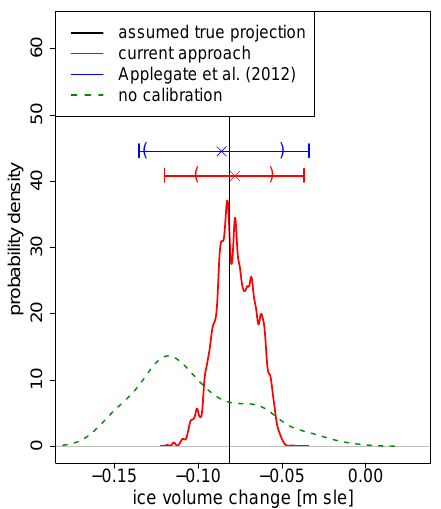
Figure 5. Illustrative (not “real”) ice volume change projections be- tween 2005 and 2100, based on three different methods: (i) the prior density of the input parameters (dashed green line); (ii) parameter settings that pass the 10% ice volume filter used by Applegate et al. (2012) (solid blue line); and (iii) the posterior density computed by our calibration approach (solid red line). The vertical line shows the ice volume change projection for the assumed-true parameter setting. The horizontal lines and the parentheses on them represent the range and the 95% prediction intervals, respectively; the crosses indicate the median projection from each method. The width of the 95% projection interval from our methods is narrower than if sim- pler methods are applied (blue box plot; Applegate et al., 2012). Similar results are obtained if different model runs from the ensem- ble are left out (see Fig. S5 in the Supplement). See text for discus- sion. The notation msle stands for meters of sea level